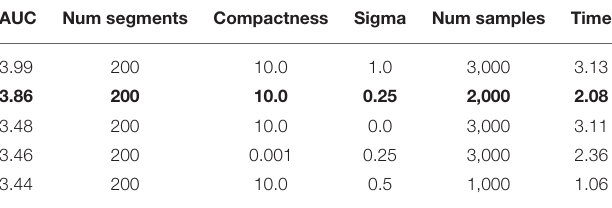
TABLE 6 | Best parameters for LIME with SLIC segmentation. AUC